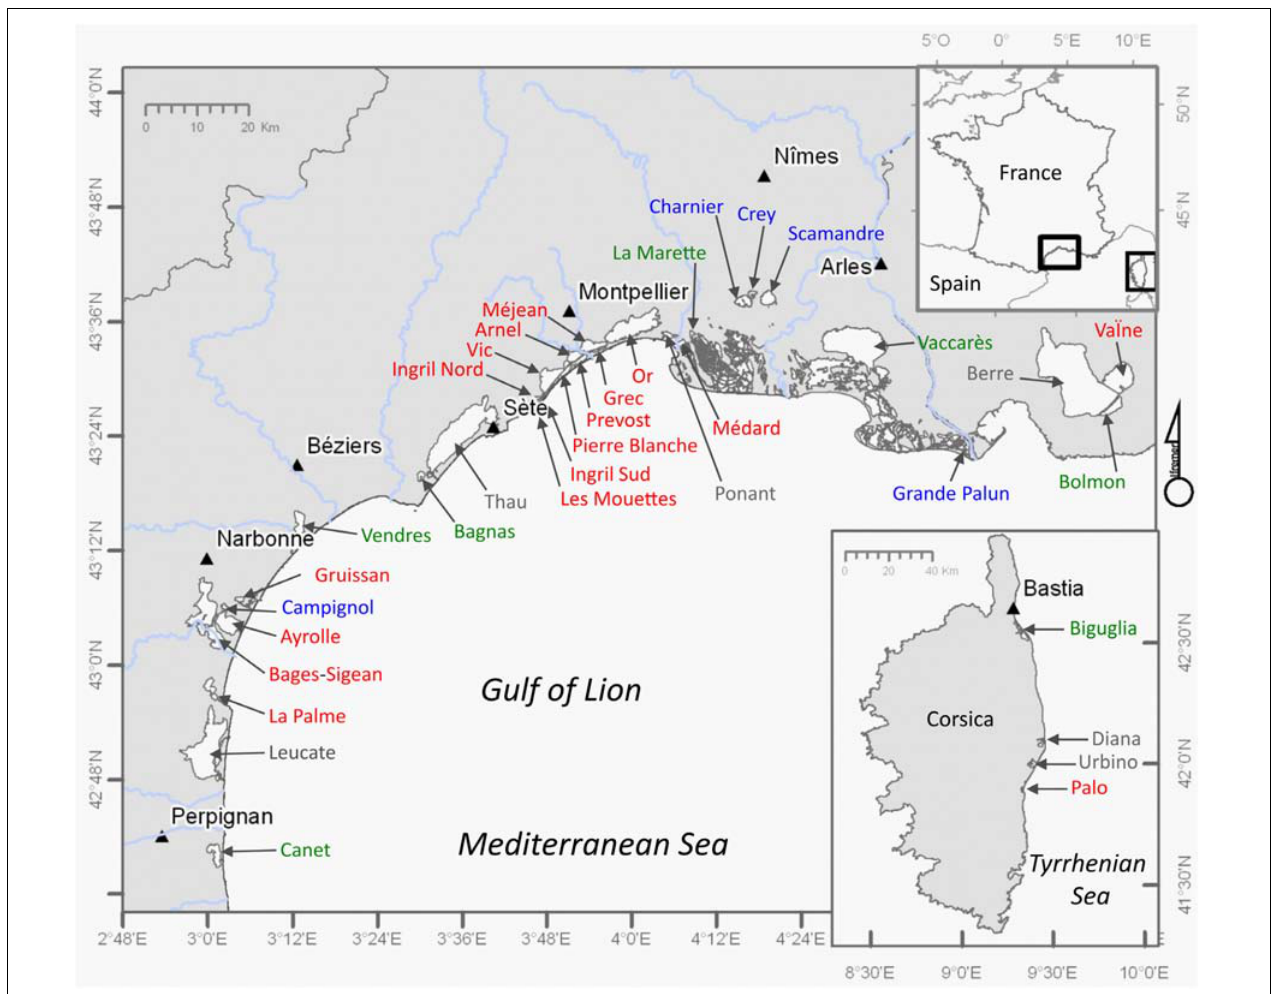
FIGURE 2 | Distribution of coastal lagoons, recognized for the WFD implementation in France, along the Mediterranean coastlines of continental France and the island of Corsica. In gray: deep lagoons ( > 2 m) not considered in this study. In blue: shallow ( < 2 m) oligohaline lagoons; in green: shallow ( < 2 m) mesohaline lagoons; in red: shallow ( < 2 m) poly- and euhaline lagoons. Triangles represent main urban centers ( > 40,000 inhabitants) in the proximity of the coastal